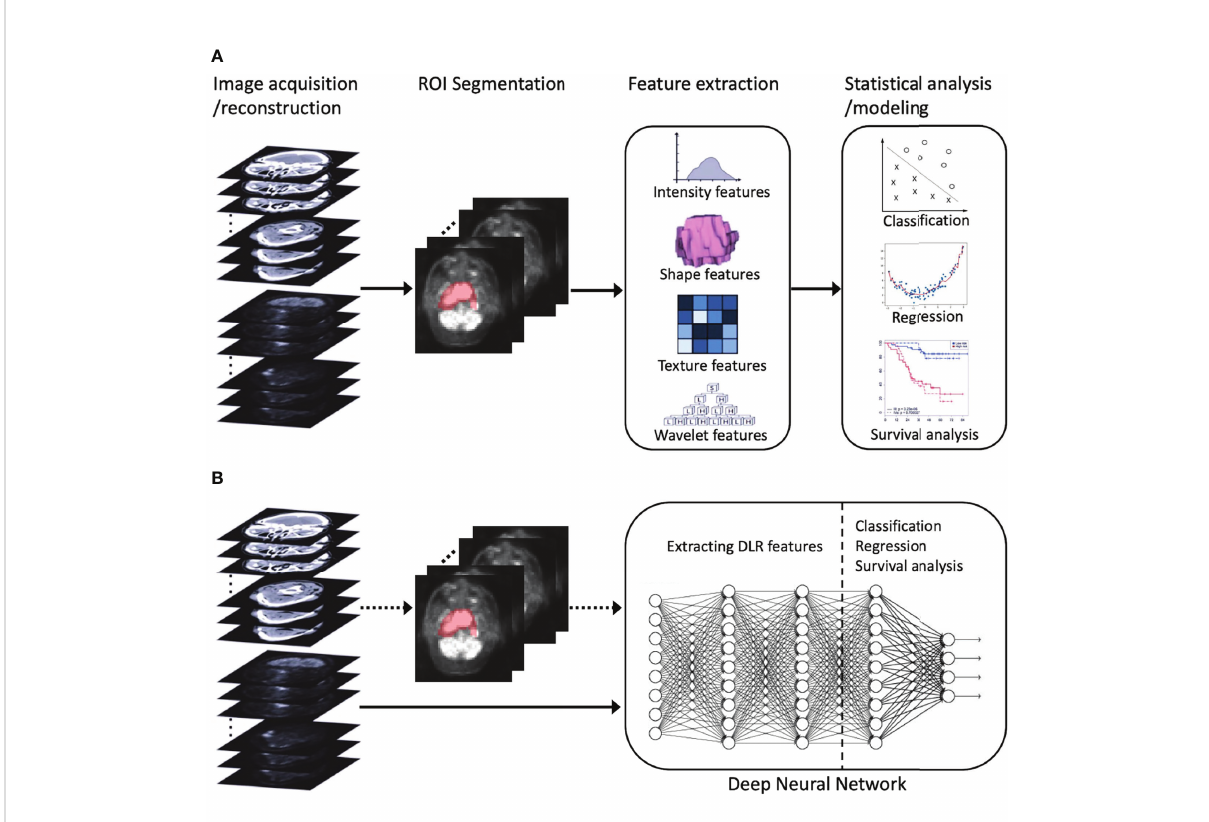
FIGURE 1 An illustration of radiomics process. (A) Conventional radiomics consisting of four steps: image acquisition/reconstruction, ROI segmentation, feature extraction, and statistical analysis/modeling. (B) DLR, its feature extraction and analysis are jointly learned using a deep neural network. The dotted arrow indicates the optional ROI segmentation operation. ROI, region of interest; DLR, deep learning-based